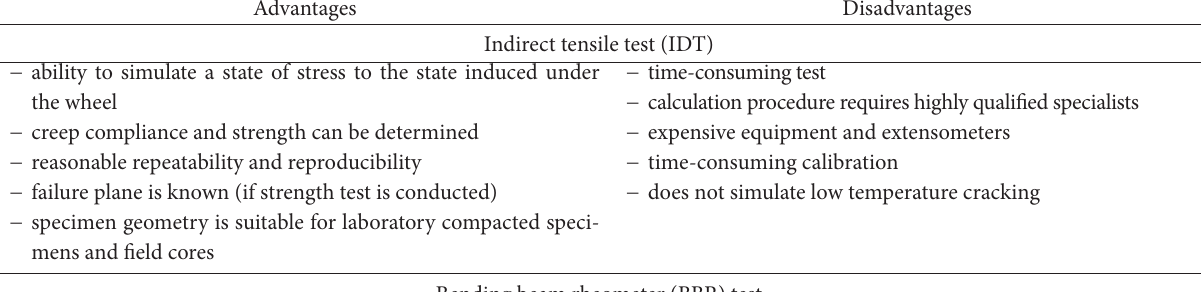
Table 1. Advantages and disadvantages of tests used to evaluate asphalt mixture resistance to low temperature